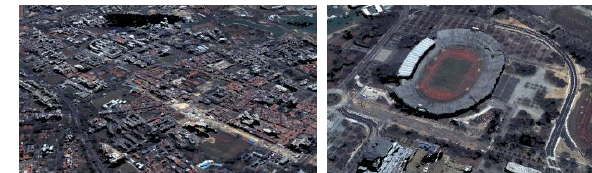
Figure 6. DSM and point clouds from IKONOS dataset generated by RSP. Top: grey-level coded DSM. Bottom, colorized point clouds.